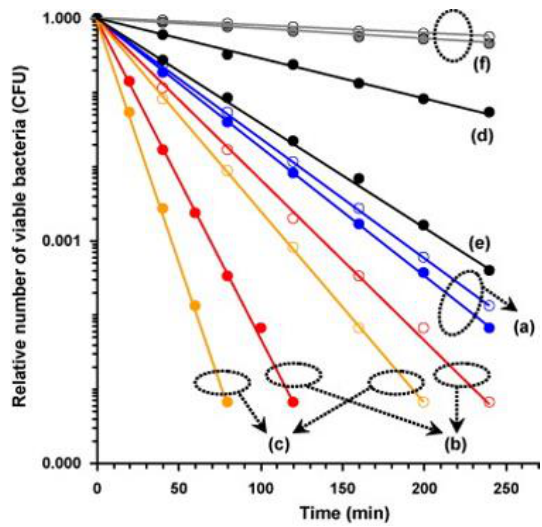
Figure 7. Relative number of viable E. coli on surface of ( a ) the anatase TiO 2 ( b ) the α-Fe 2 O 3 and ( c ) the TiO 2 /Fe 2 O 3 thin films under visible light irradiation. ( d ) The α-Fe 2 O 3 and ( e ) the TiO 2 /Fe 2 O 3 thin films without light illumination. ( f ) Control samples containing the solution without H 2 O 2 ( ○ ) and with H 2 O 2 (●) with light illumination. The black circles indicated the samples of a, b, c and f containing the solution without H 2 O 2 ( ○ ) and with H 2 O 2 (●) with light illumination. Reproduced with permission from ref. [85]. Copyright © 2009, Elsevier.